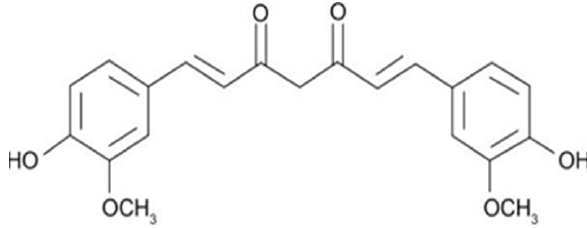
Figure 1. Chemical structure of curcumin.